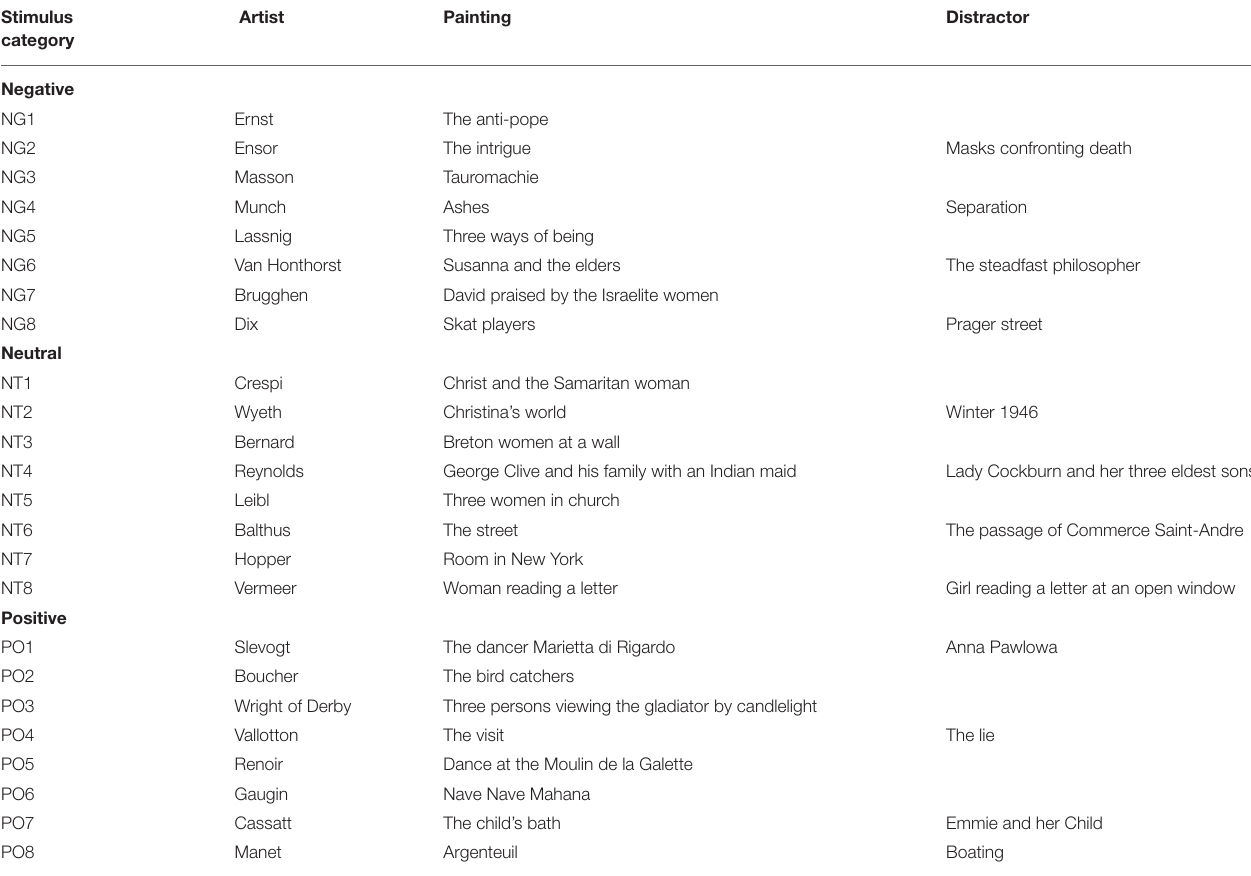
TABLE 1 | List of stimuli used in the preference ranking and the recognition memory task. Stimulus category